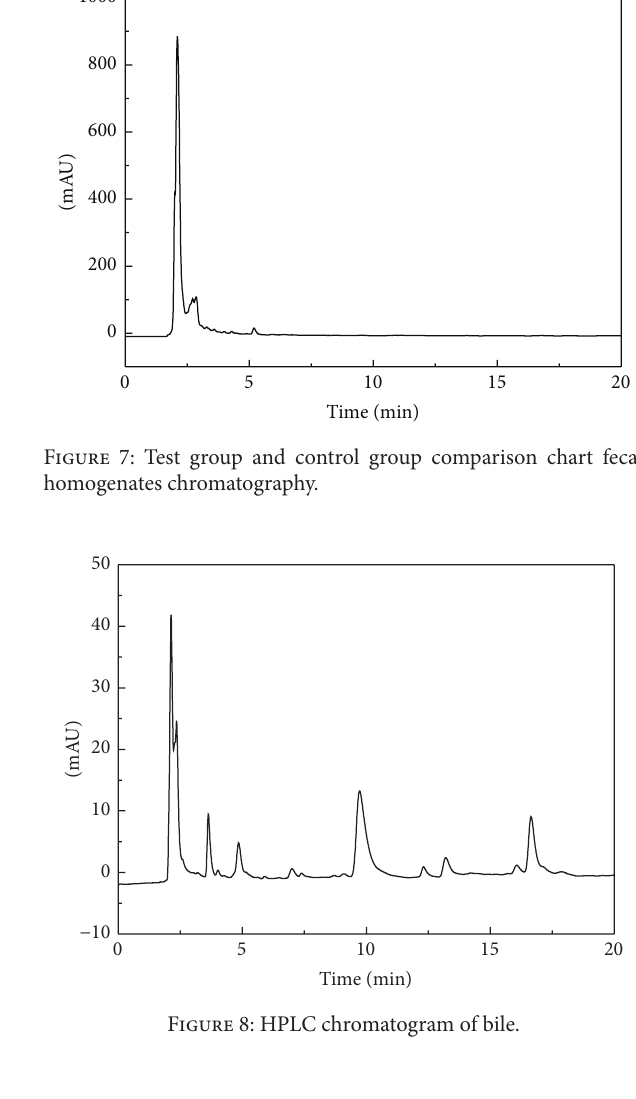
Table 4: Feces baicalin and baicalein content (ug/g feces).